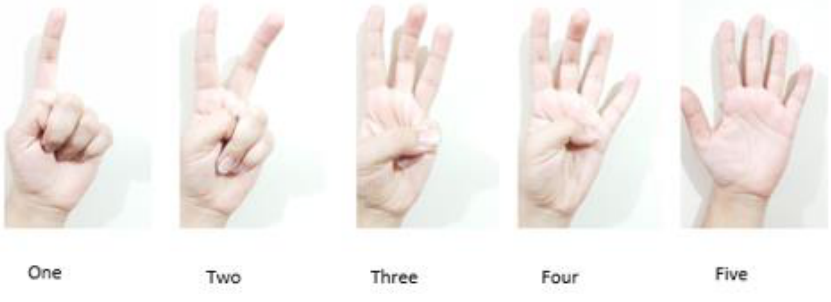
Figure 1. Hand gesture set to be detected.